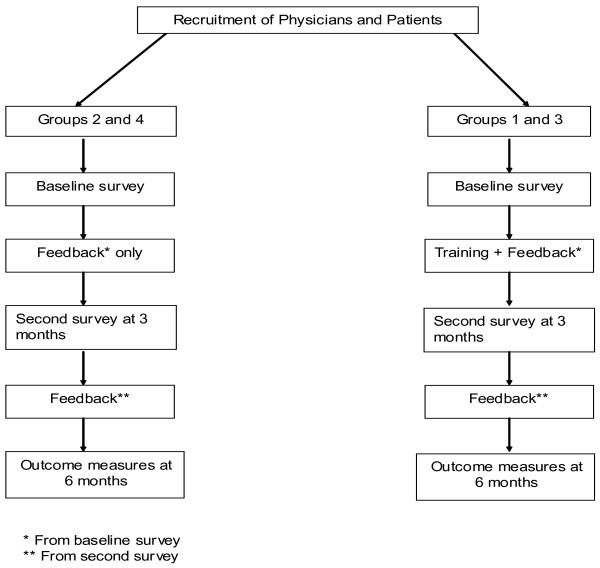
Flowchart showing recruitment, intervention and outcomeassessment. * From baseline survey. ** From second survey